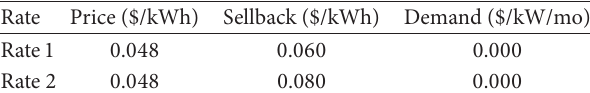
Table 4: Rate schedule (Step 1: define and select a rate).